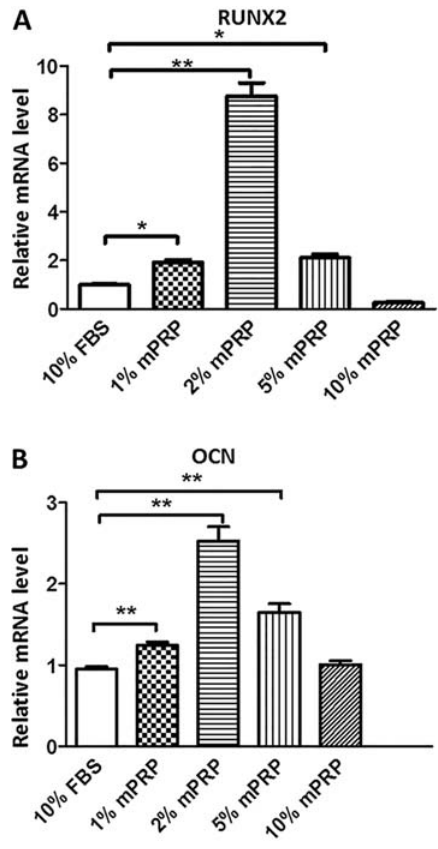
Figure 4. Effect of different concentrations of modi fi ed platelet- rich plasma (mPRP) on mRNA expression of RUNX2 ( A ) and OCN ( B ) in stem cells from human exfoliated deciduous teeth (SHEDs) cells, by quantitative real-time PCR. *P o 0.05, **P o 0.01 vs control group (Student ’ s